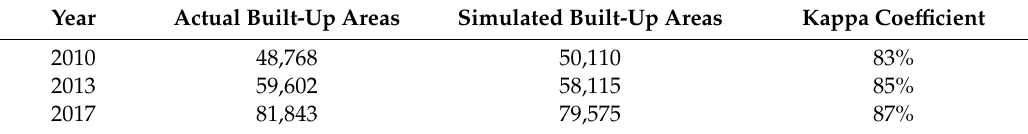
Table 2. The comparisons between actual areas and simulated areas in 2010, 2013, and 2017 (unit: m 2 ). Year Actual Built-Up